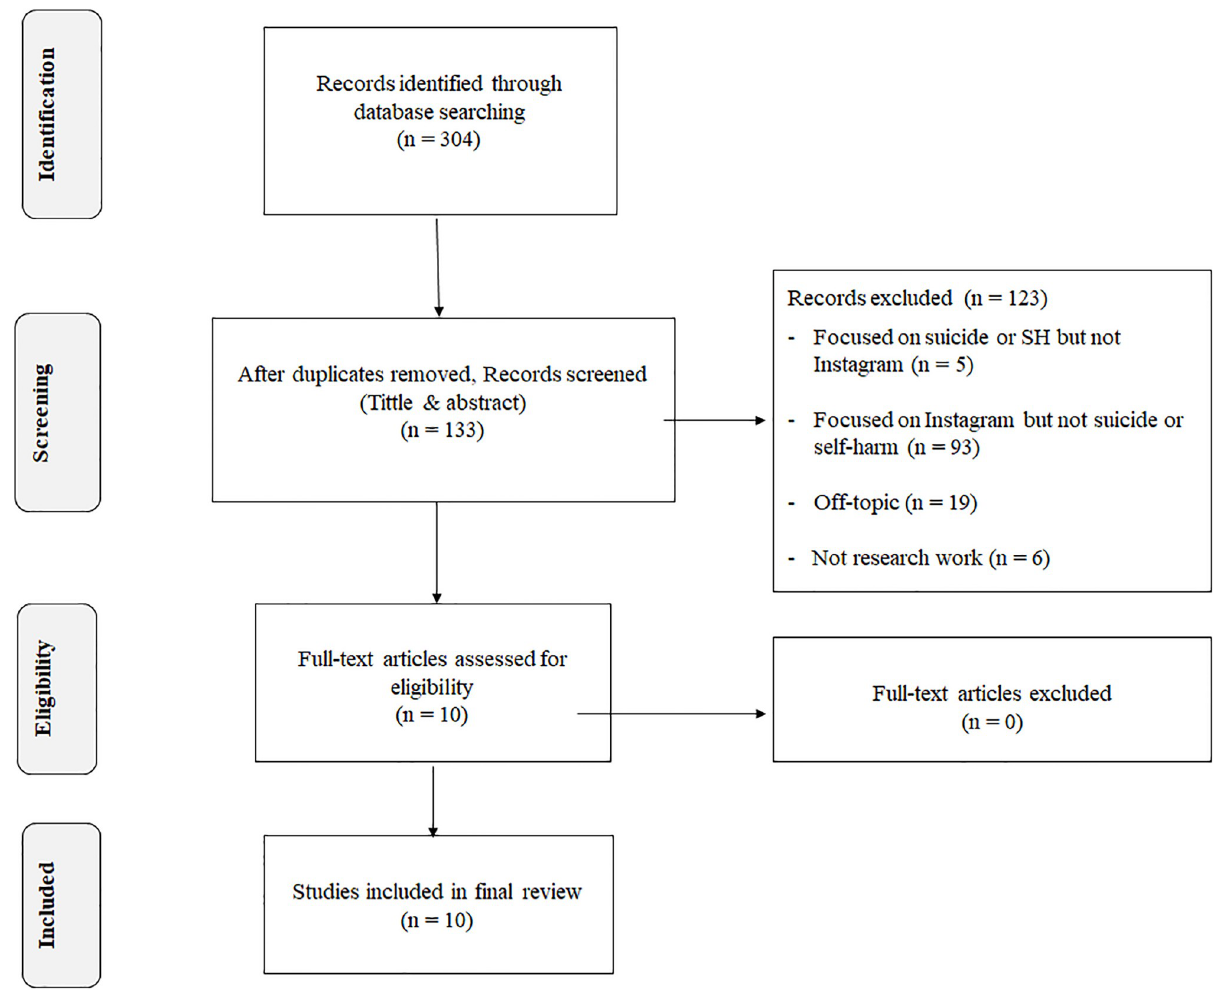
Fig 1. Articles selection. PRISMA flow diagram of articles selection process [31].